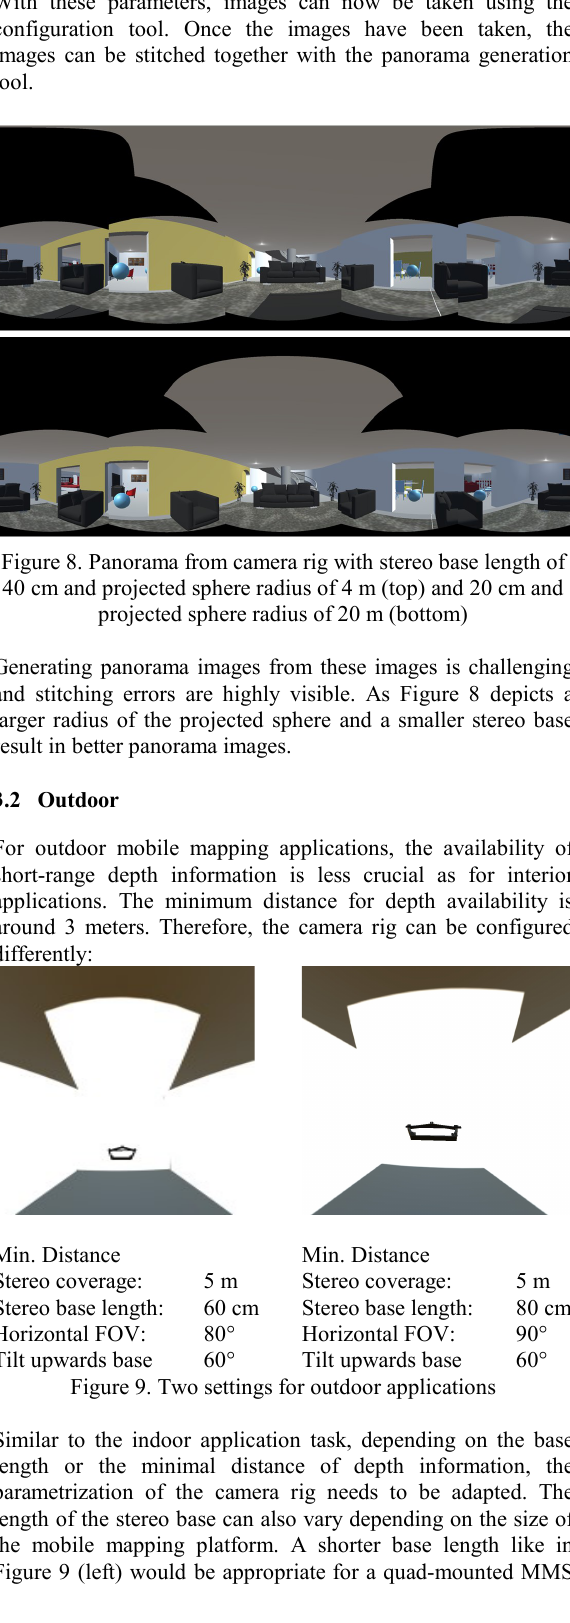
length of the stereo base can also vary depending on the size of the mobile mapping platform. A shorter base length like in Figure 9 (left) would be appropriate for a quad-mounted